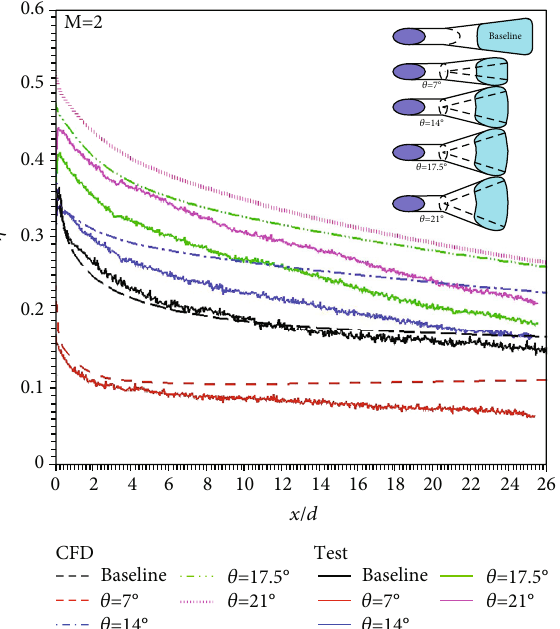
Figure 23: Streamwise variation of test and CFD fi lm e ff ectiveness (spanwise-averaged at each point) for the blowing ratio of 0.5.